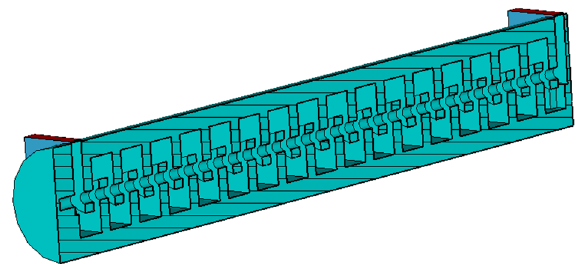
Figure 15. Cross-sectional view of SWS with T-coupler.